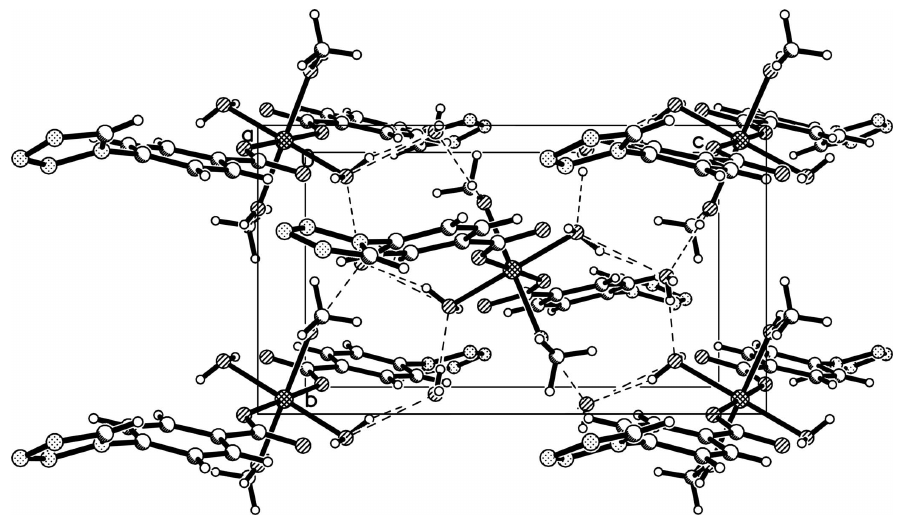
Figure 2 A portion of the crystal stacking structure, showing the intermolecular O—H···O, hydrogen bonds as dashed